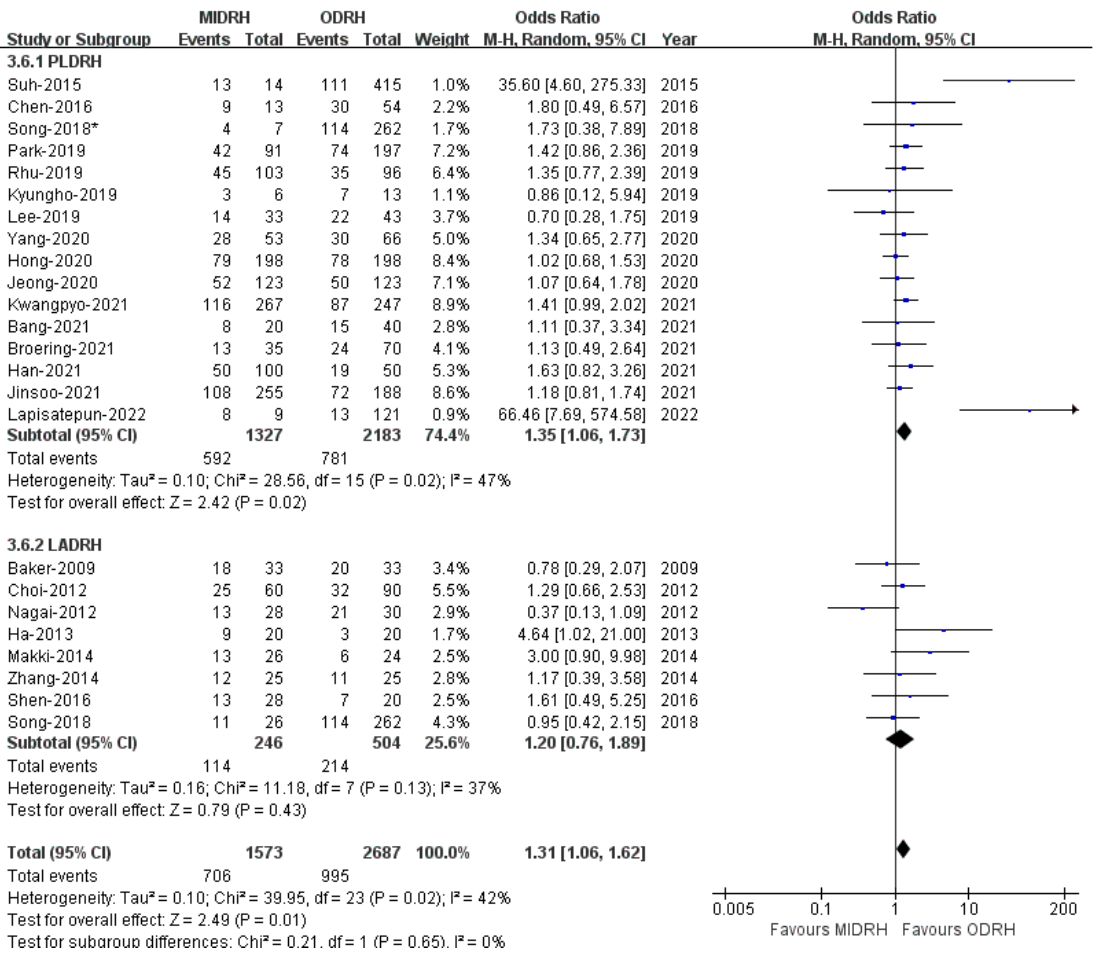
Figure 2. Forest plot of comparison of MIDRH versus ODRH for age [4–7,12–17,19–23,25–31]. * ： Different data in the same article .